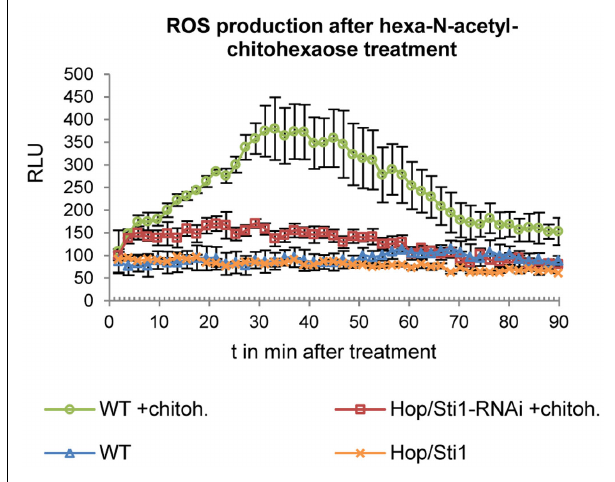
FIGURE 2 | Detection of ROS production in response to hexa- N -acetyl-chitohexaose treatment in wild-type plants and in Hop/Sti1-RNAi line #61. Luminescence is given in relative luminescence units (RLU), error bars represent the standard error.